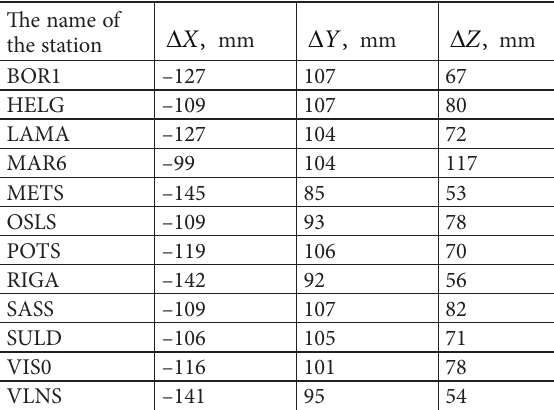
Table 4. The displacements of the coordinates of the stations between 2004 and 2011 according to measurement data from GPS stations The name of the station